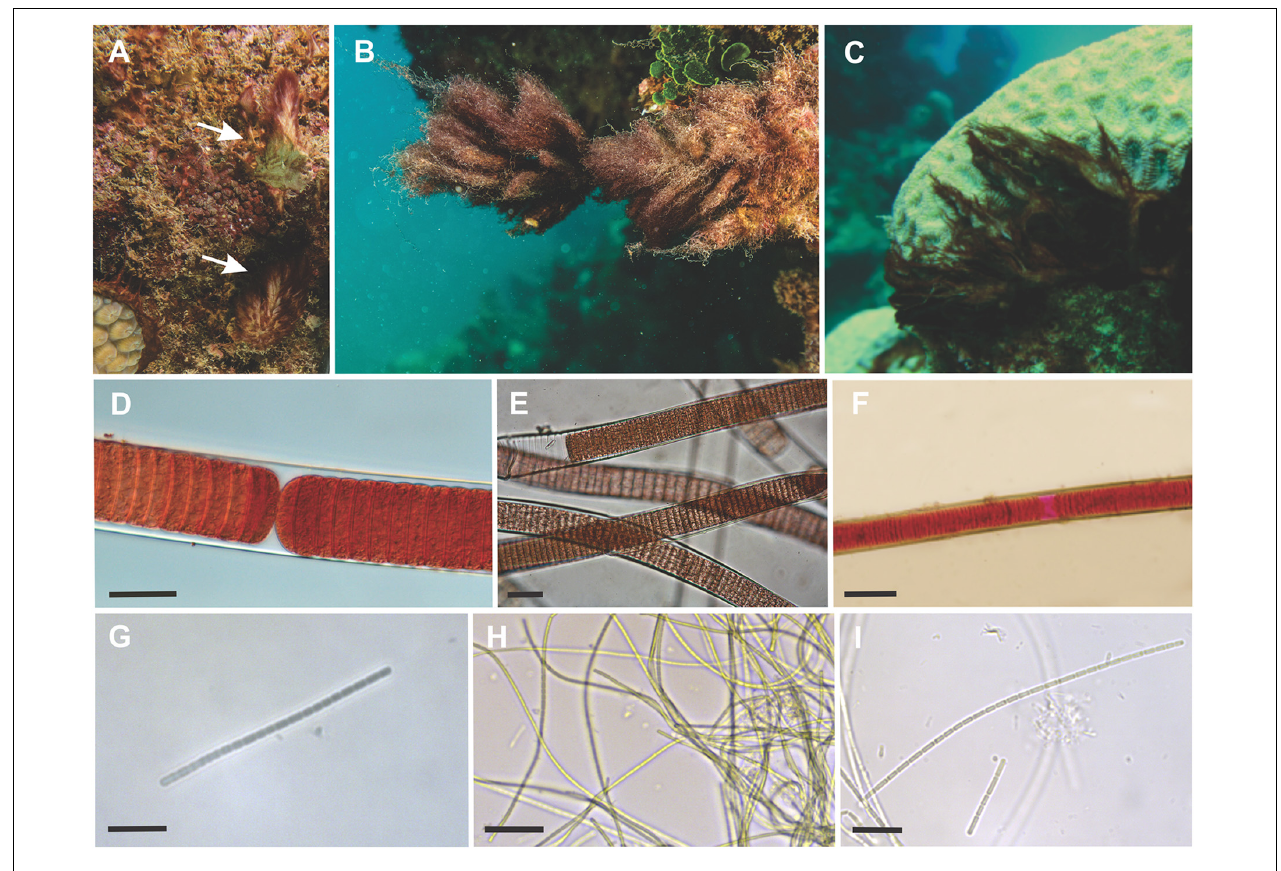
FIGURE 2 | (A–C) Macroscopic aspect of BCMs observed in Abrolhos: (A,C) BCMs from PAB composed of M. bouillonii (predominant), A. Turfae, and Halomicronema sp.; (B,F) BCMs from PLES composed of O. erythroflocculosa (predominant), A. Turfae, and Leptolyngbya sp.; (D–I) General aspect of cyanobacterial filaments associated with BCMs; (D,E) M. bouillonii ; (F) O. erythroflocculosa ; (G) Leptolyngbya sp.; (H) A. turfae ; (I) Halomicronema sp. Scale bars: panel (H) = 25 µ m; panel (D) = 30 µ m; panel (E) = 50 µ m; panel (F) = 100 µ m; panels (G,I) = 10 µ m.